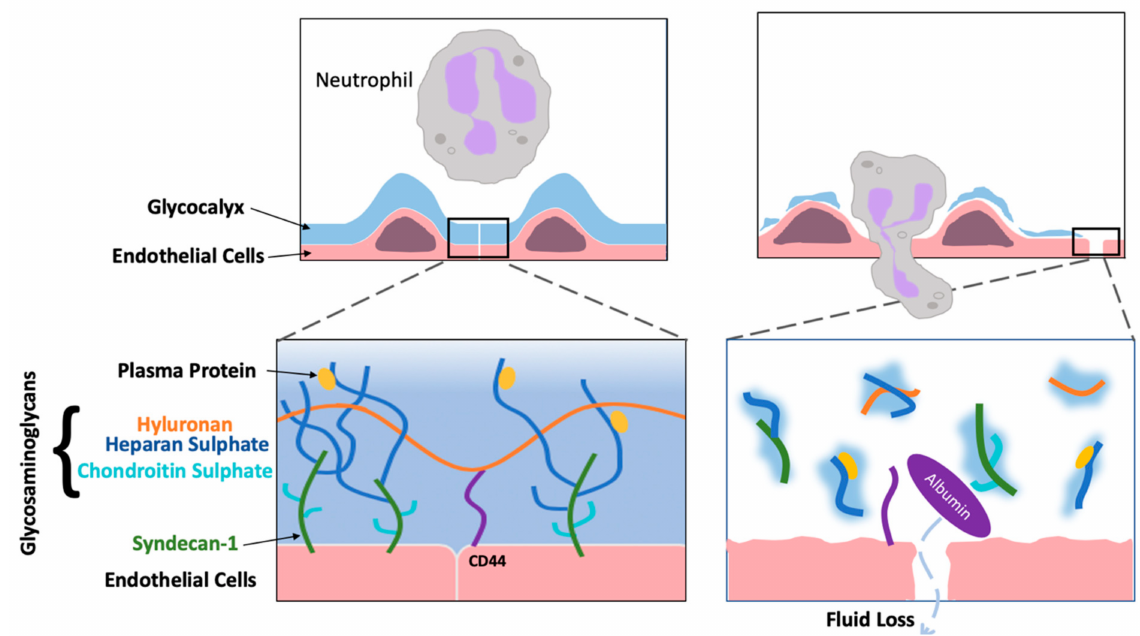
Figure 1. EG structure during health ( left ) and degradation ( right ). Disease causes thinning of the glycocalyx. Glycocalyx constituents are released into the plasma. An inflammatory response is produced with the recruitment of leucocytes and the loss of